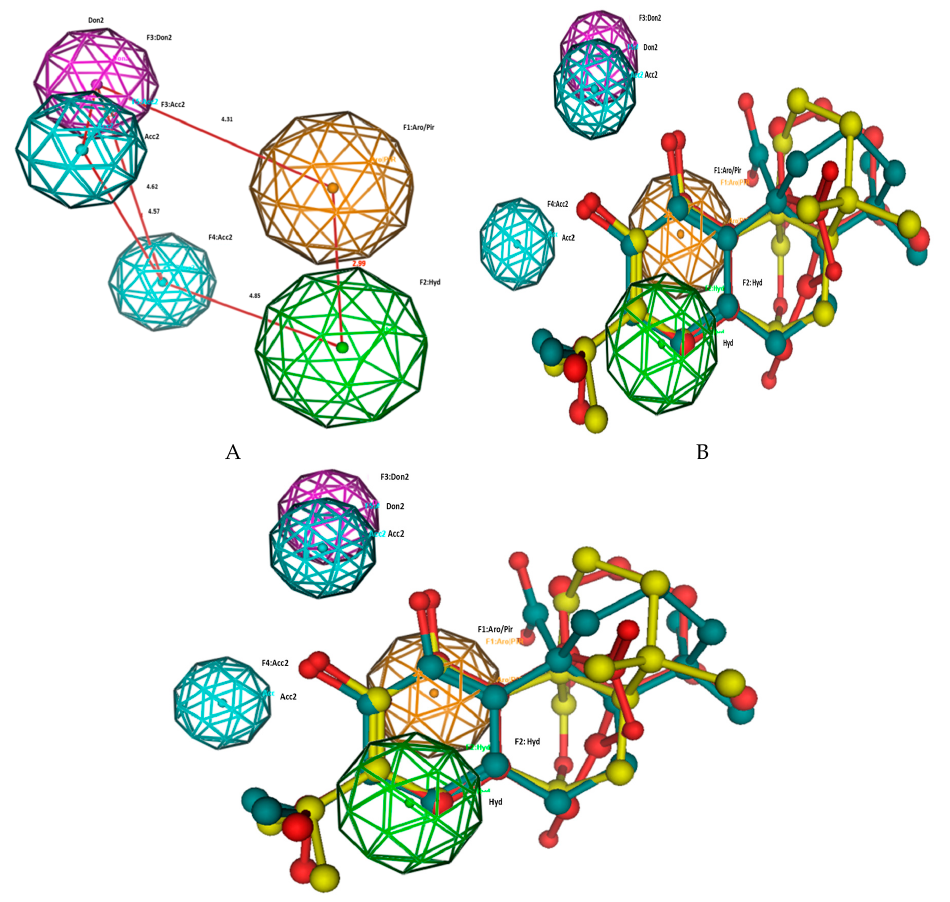
Figure 2. Pharmacophore model and structure requirements of the isolated compounds carnosol, carnosic acid and rosmanol as antioxidant agents. ( A ) Pharmacophiric model of compounds, distances are measured in Å. ( B ) Alignment of the most active compounds carnosol, carnosic acid and rosmanol on the pharmacophore model. ( C ) Superimpositions of the pharmacophore model on rosmanol. Aro/Pir; aromatic, Don; H-bond donner, ACC; H-bond acceptor, Cat and Ani; cationic and anionic.